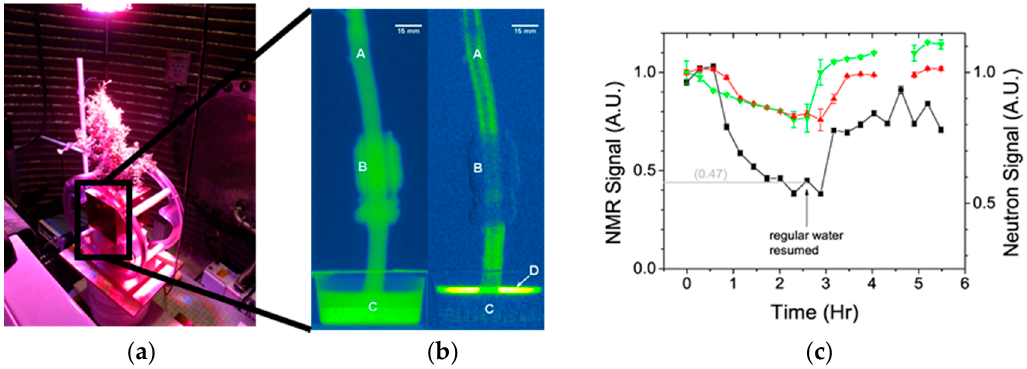
Figure 12. A photograph of a juniper branch in the combined neutron radiography-and NMR set-up on 1FP-05 60 m station ( a ). Neutron radiographs of the branch ( b ) and time series of the neutron and NMR signal intensity during a D 2 O labeling and watering experiment on this juniper branch using an a-Si flat panel with GadOx scintillator screen ( c ). See text for details.